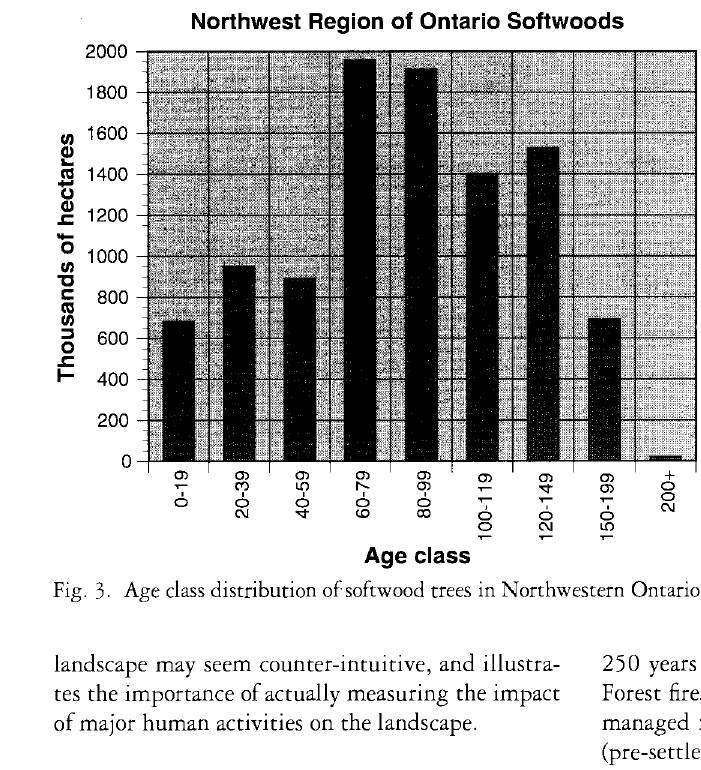
Age class distribution of softwood trees in Northwestern Ontario